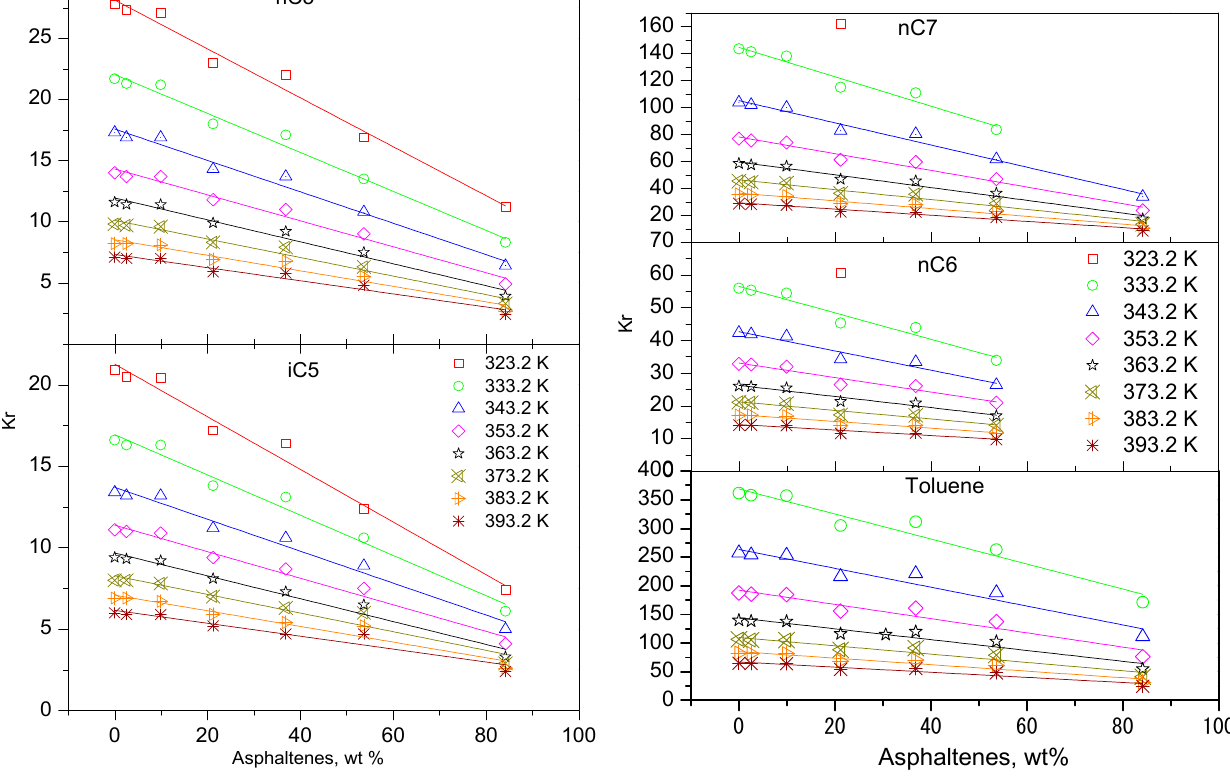
Figure 3. Linear plots for partition coefficient K R vs. the different asphalting contents for different absolute temperature T (333.2 K, 343.2 K, 353.2 K, 363.2 K, 373.2 K, 383.2 K, and 393.2 K) for different dilution: nC5, iC5, nC6, nC7, and Toluene.